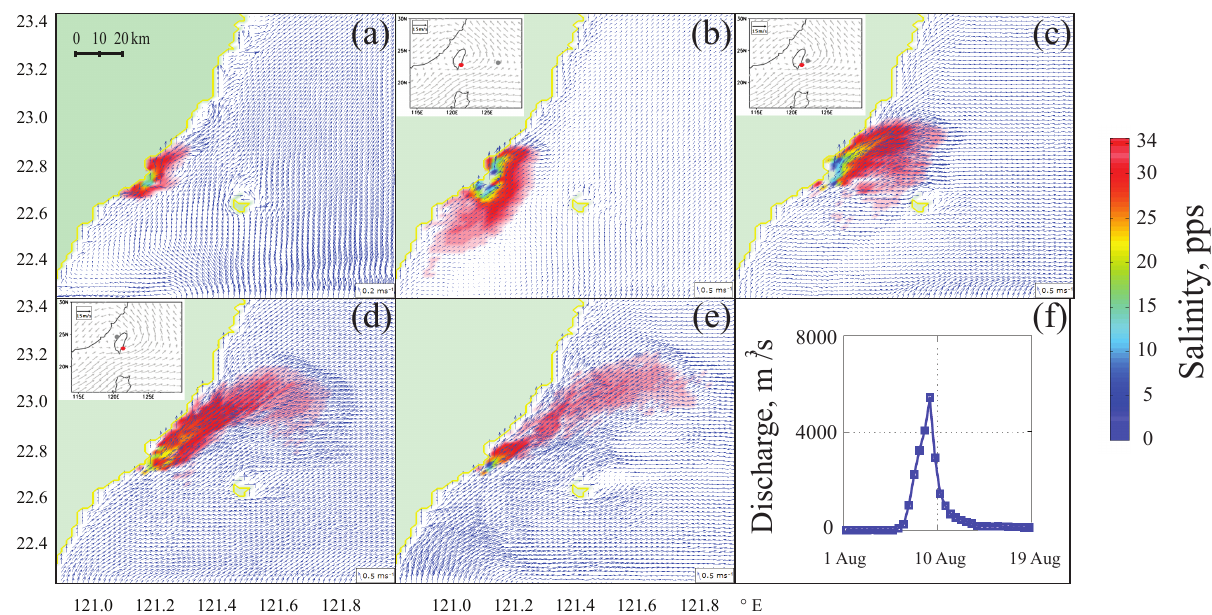
Figure 7. The Peinan River plume under typhoon conditions before (a) , on the first (b) , the second (c) , the third (d) , and the fifth (e) day of typhoon simulation. The left bottom panel (f) shows the discharge rate of the Peinan River in August 2009 during Typhoon Morakot (after Mirabito et al., 2012). Deposition of the center of the 700hPa typhoon (gray solid dot) and the Peinan River estuary (red solid star) are shown in the insets in (b) – (d) (after Wu et al.,